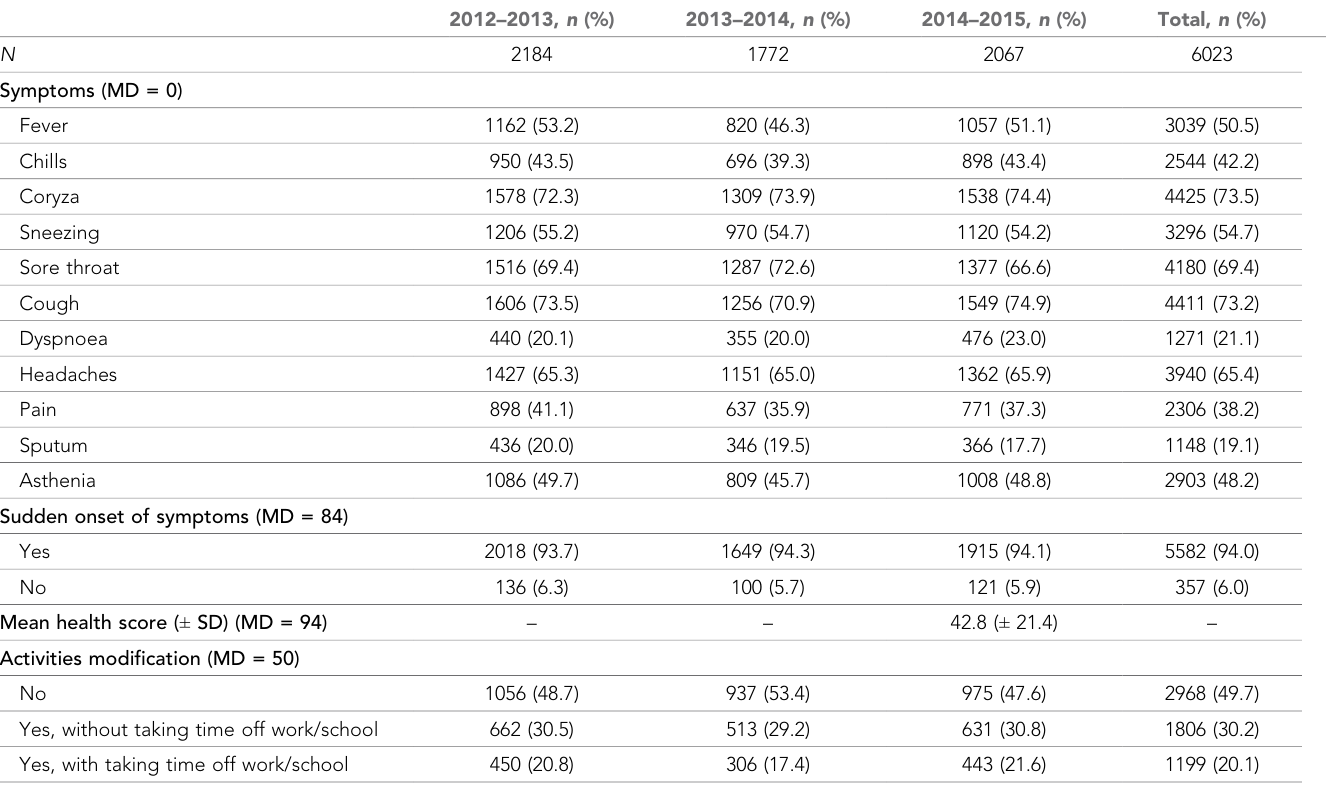
Table 3. Characteristics of ILI episodes reported by participants included in the